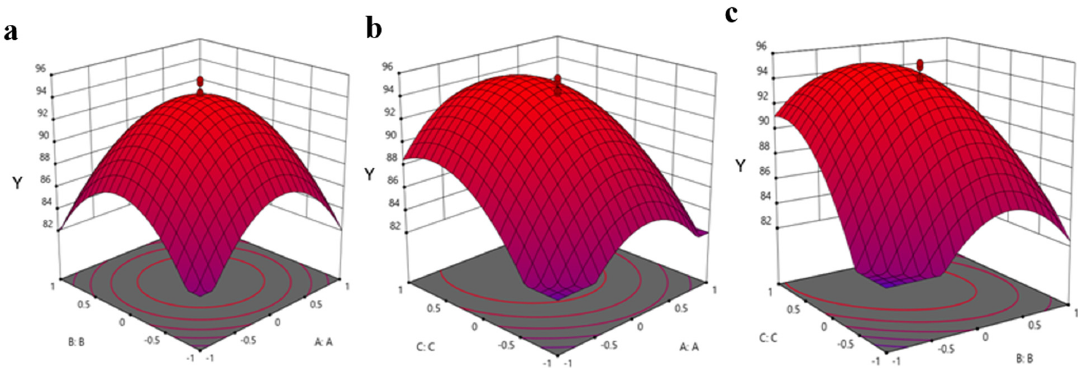
Figure 3. Optimization of the allethrin degradation condition using response surface methodology. Response surface plots showing the interactive effects of pH ( a ), temperature ( b ), and incubation time ( c ) on allethrin degradation (Y) with strain CF2.